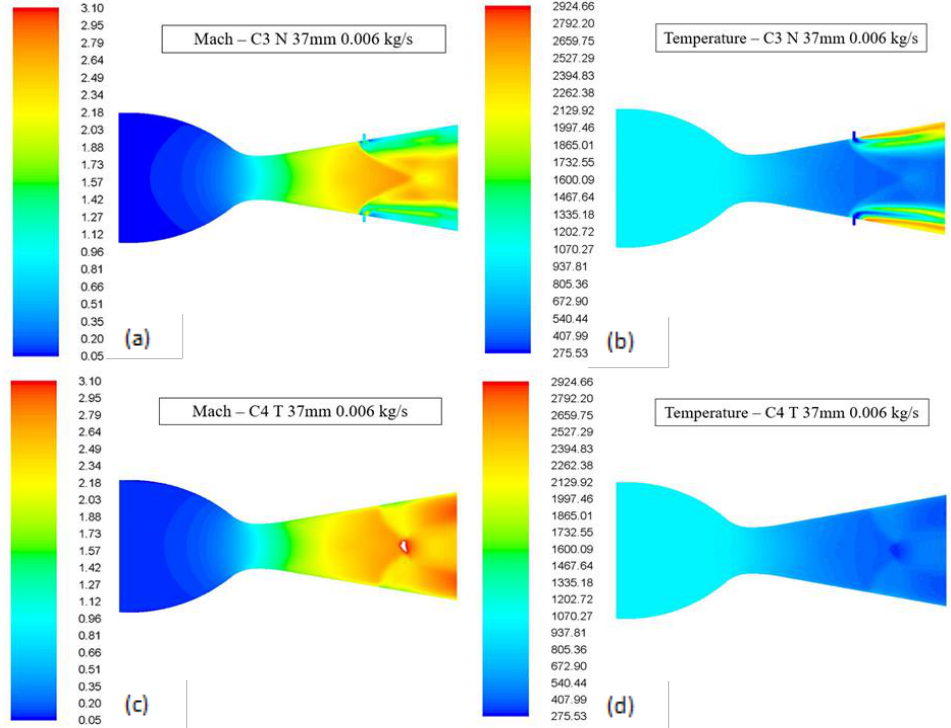
Figure 10. ( a , b ) Normal injection-Mach number and static temperature. ( c , d ) Tangent injection-Mach number and static temperature.